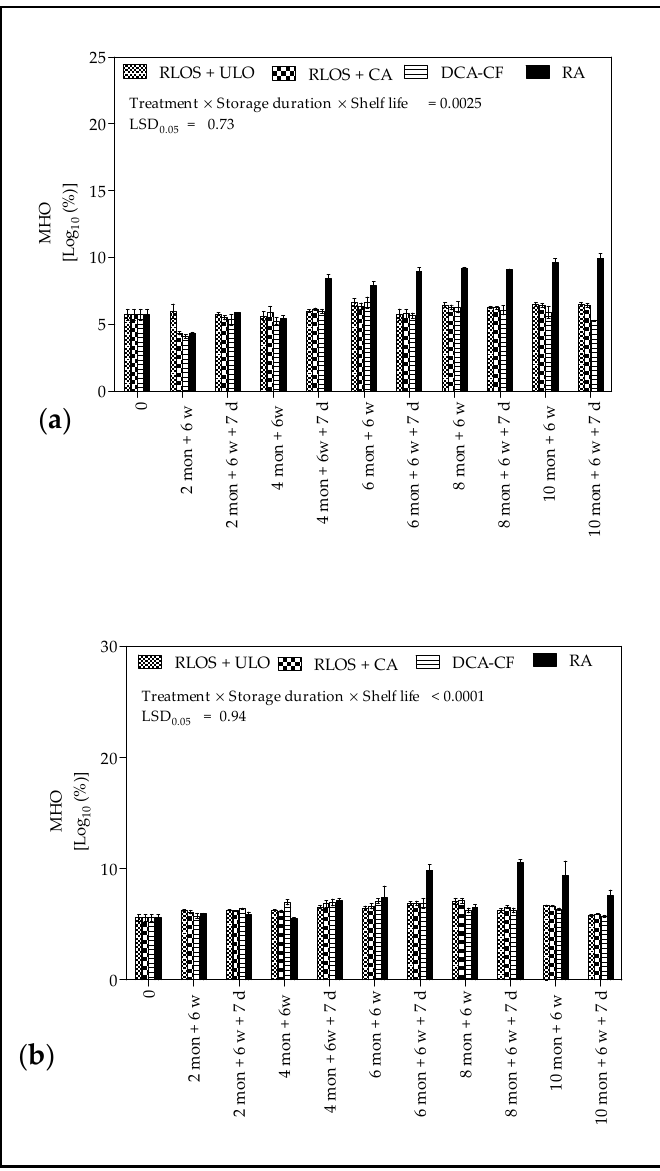
Figure 6. Accumulation of MHO (Log (%)) of ‘Granny Smith’ apples harvested in the 2015 ( a ) and 2016 ( b ) seasons at commercial maturity and stored for up to 10 months at 0 °C in various storage conditions, evaluated every two months followed by a 6 week simulated shipment and handling period, and at 7 days on the shelf (20 °C and 65% RH). Vertical bars represent the standard error (SE) of mean values of 3 replicates (1 replicate = 10 fruit). LSD 0.05 represents least significant difference ( p < 0.05). For storage duration, mon—months; w—weeks; and d—days. RLOS—repeated low oxygen stress; ULO—ultra-low oxygen; CA—controlled atmosphere; DCA-CF—dynamic controlled atmosphere-chlorophyll fluorescence; RA—regular atmosphere.